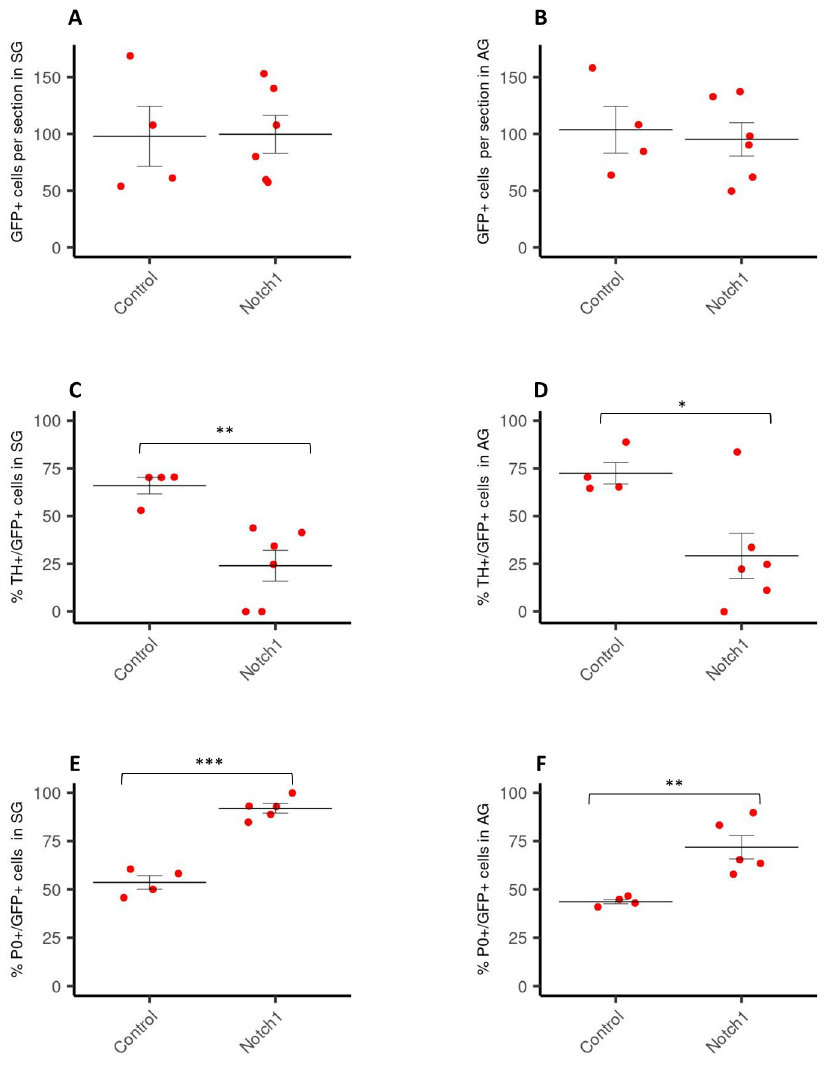
Fig 2. Analysis of TH+/GFP+ and P0+/GFP+ cells in SG and AG following overexpression of Notch. Number of GFP-positive cells per section (% of control) in sympathetic ganglia (SG) (A) and the adrenal gland (AG) (B) of E6 chick embryos after electroporation with Notch1 at E2. Amount of TH+/GFP+ cells (% of the total number of GFP- positive cells) in SG (C) and AG (D) of E6 chick embryos after electroporation with Notch1 at E2 (control = 4, Notch1 = 6). Amount of P0+/GFP+ cells in SG (E) and AG (F) of E6 chick embryos after electroporation with Notch1 at E2 (control n = 4, Notch1 = 5). Data are presented as mean +/- S.EM. � p � 0.05; �� P � 0,01; ��� P � 0,001; n: number of experimental animals. The values used to build the graphs in S2